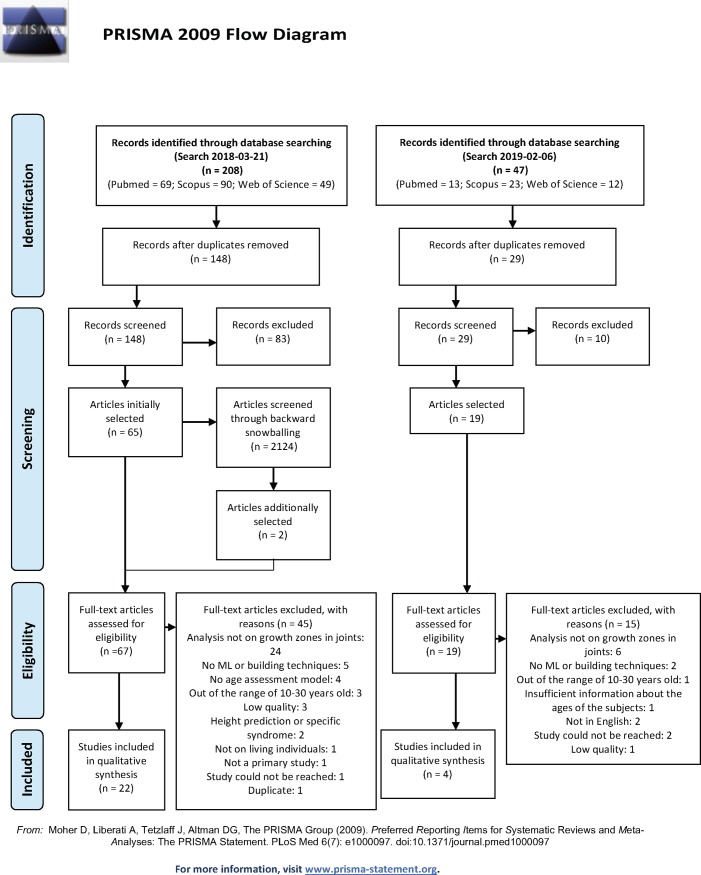
PRISMA flow chart.